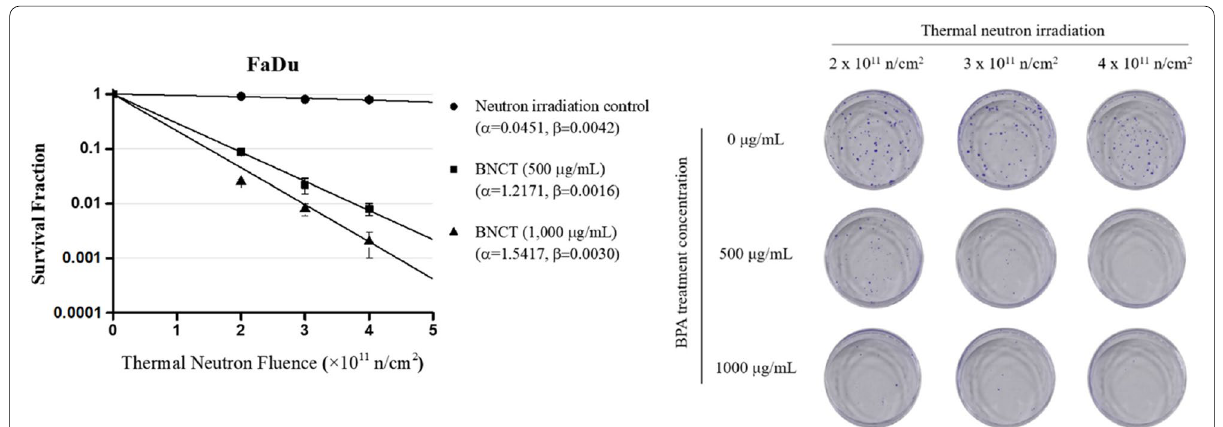
Fig. 22 Cell viability estimation after BNCT treatment for FaDu cells showing a very high therapeutic efficacy